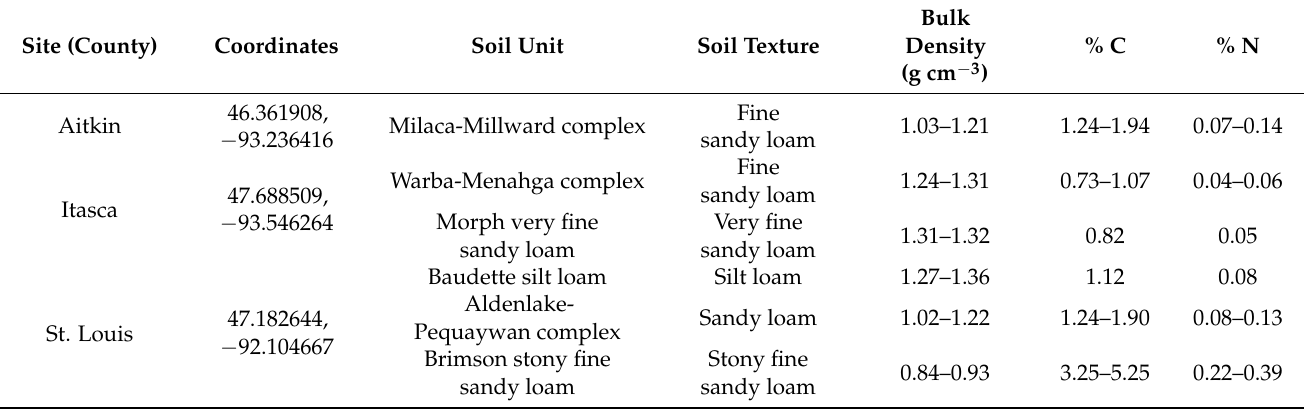
Table 1. The site locations, map units, and pre-treatment physical and chemical data for the three sites (county) determined from the soil survey information. The soil survey information is from the National Cooperative Soil Survey